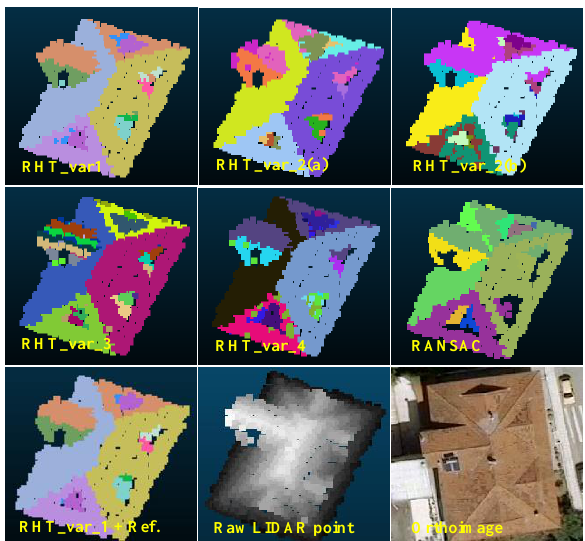
Figure 5. Plane detection of Building 2 using the variations of the RHT and RANSAC.